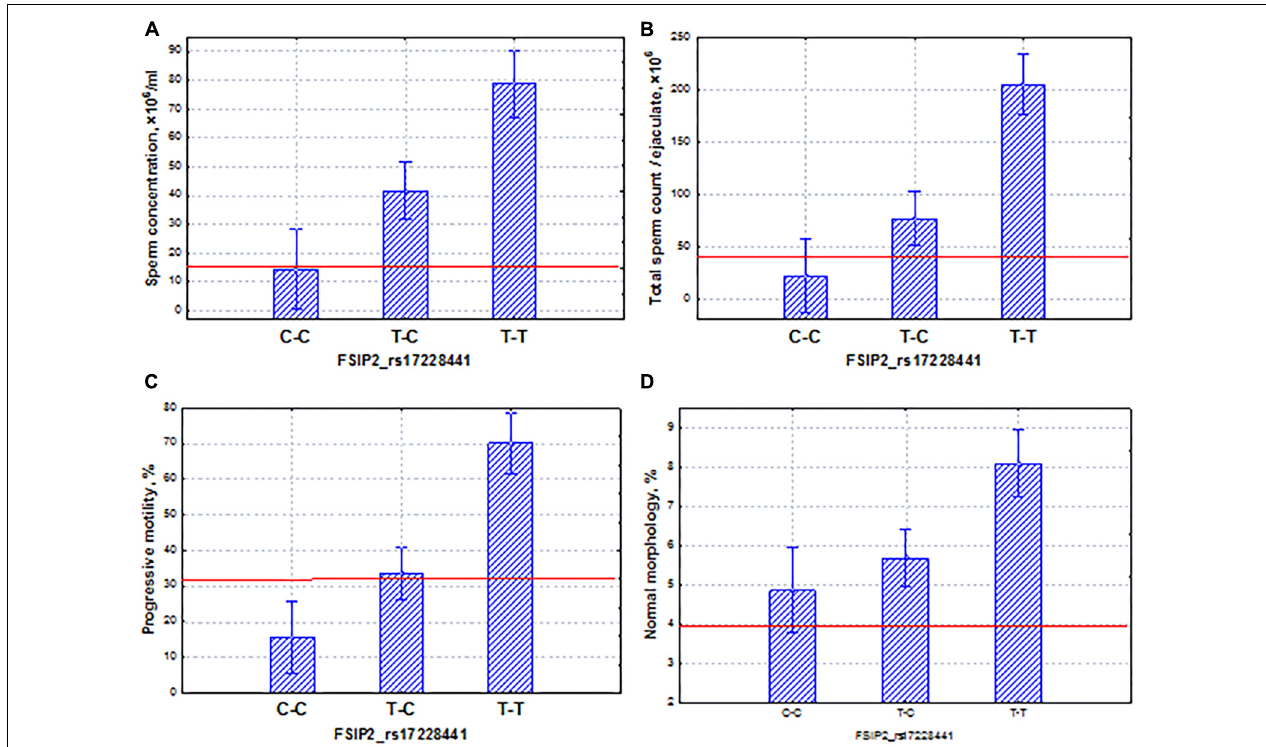
FIGURE 10 | Coordinated allelic effects of the SNP marker rs17228441 of the FSIP2 gene on semen quality parameters. (A) Sperm concentration, (B) total sperm count, and (C) proportion of motile, and (D) morphologically normal sperm. All the allelic differences were highly significant ( p < 0.005). The red lines indicate the WHO reference limits for different normal semen parameters [World Health Organization (WHO),